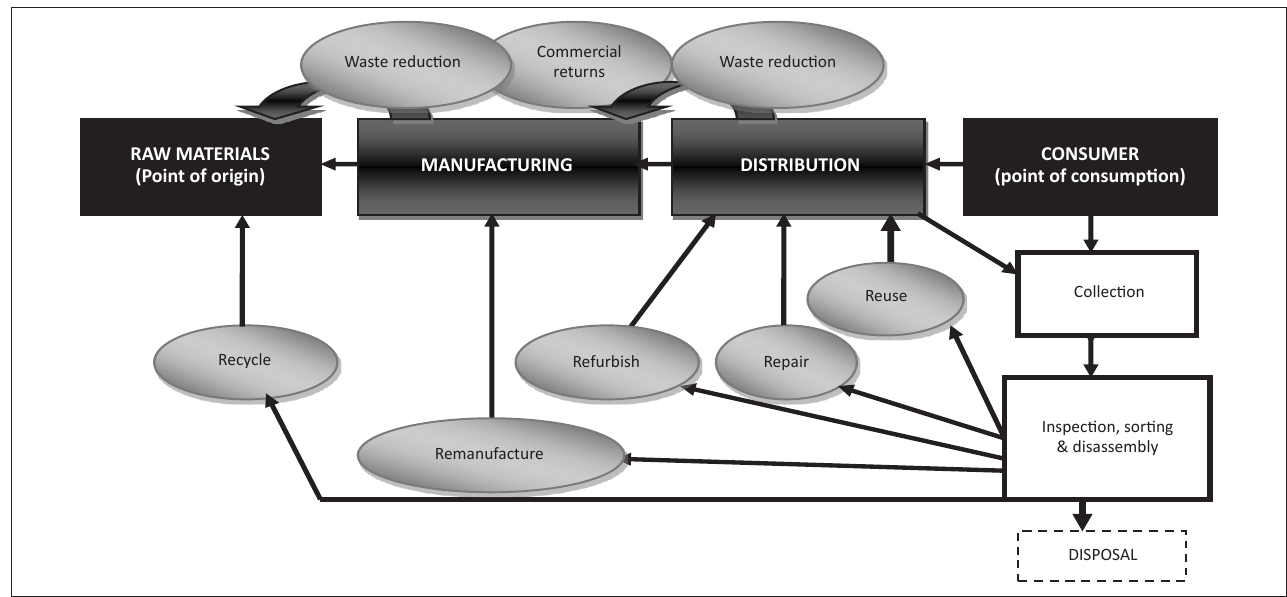
FIGURE 1: The reverse logistics